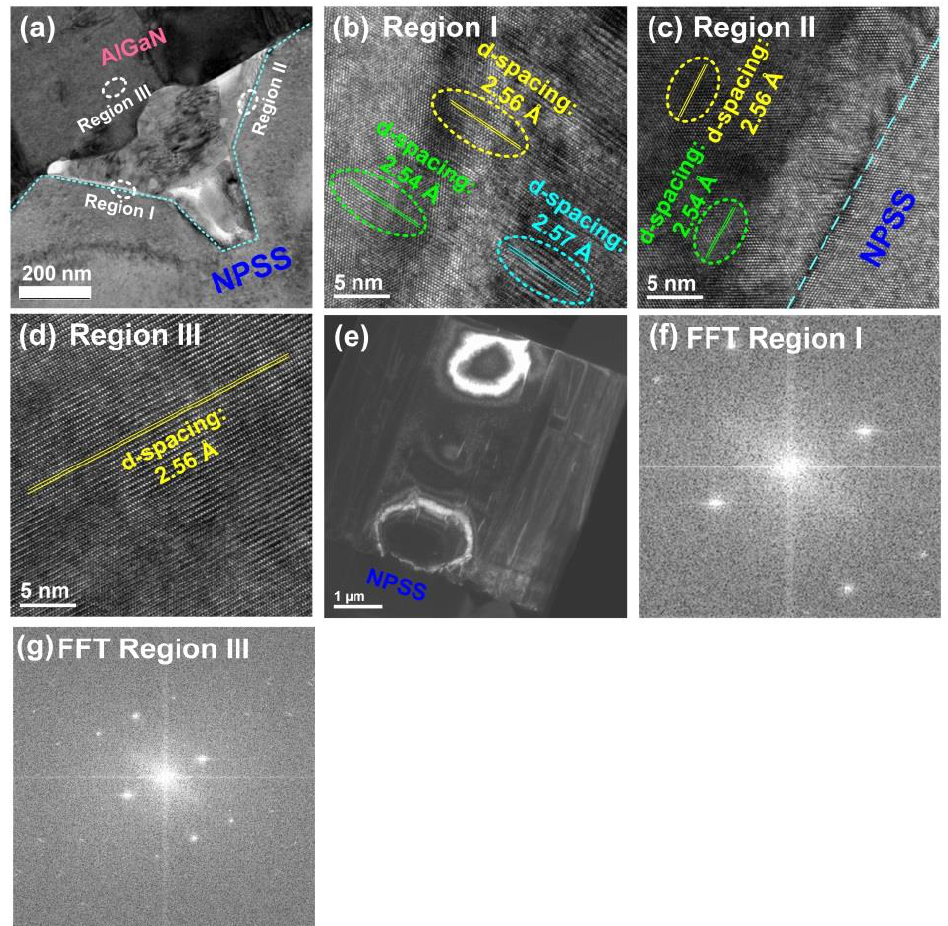
Figure 7. ( a ) A cross-sectional TEM image of the AlGaN/AlN/NPSS sample. HRTEM images focused on ( b ) region I; ( c ) region II; and ( d ) region III as indicated in Figure 7a. ( e ) The dark-field TEM image observed in the two beam condition for the AlGaN epilayer deposited on AlN/NPSS template. Fast Fourier transform images for regions ( f ) I and ( g ) III.